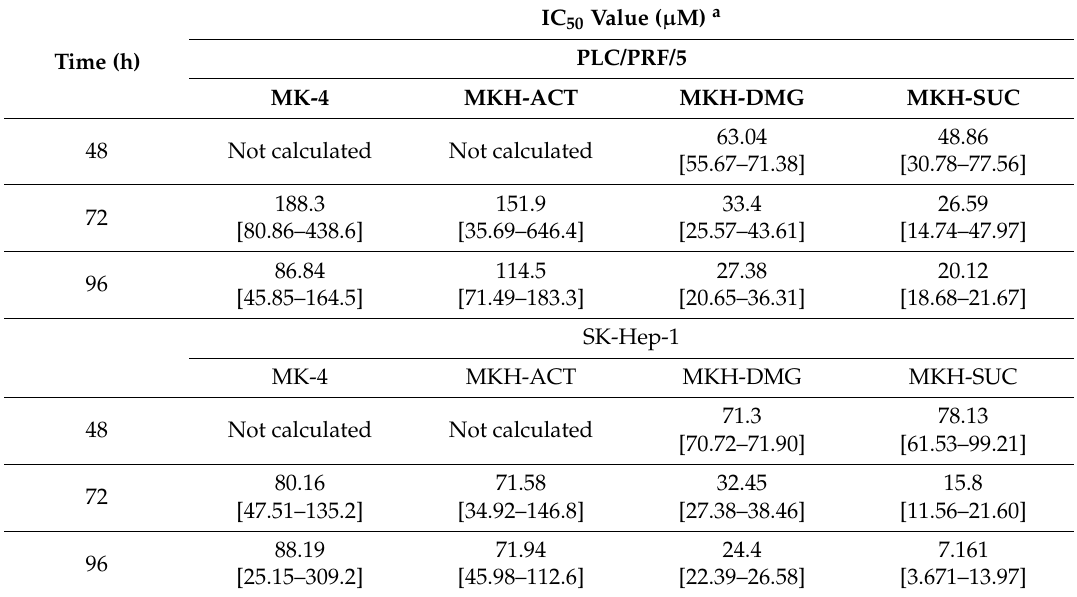
Table 4. The IC 50 values of MK-4 and MKH-ester derivatives in PLC/PRF/5 or SK-Hep-1 cells for the different incubation time